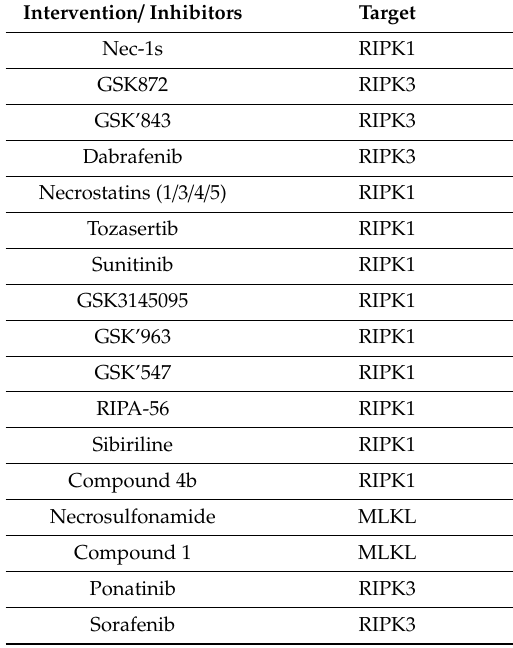
Table 2. List of necroptosis inhibitors. The table is modified from Reference